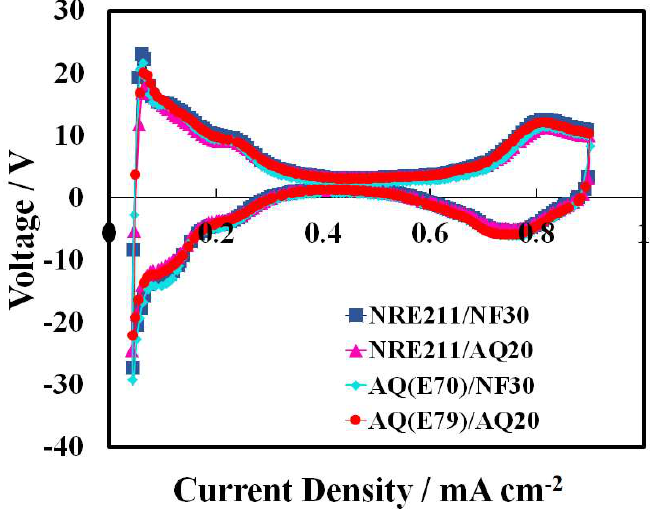
Figure 1. Typical cyclic voltammograms of cathode CLs in MEAs at 80 ◦ C and 100% RH. Table 2. Electrochemical performance of the four investigated MEAs measured at 80 ◦ C and 100% of